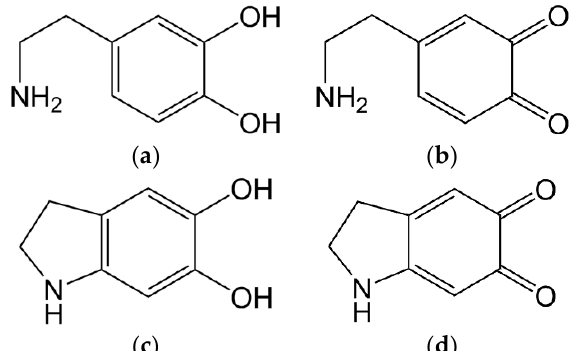
Figure 2. Formulas of chemical compounds representing intermediate steps of laccase-catalysed oxidation of dopamine ( a ) via dopamine-o-quinone ( b ) and 5,6-dihydroxyindoline ( c ), forming indole-5,6-quinone ( d ).